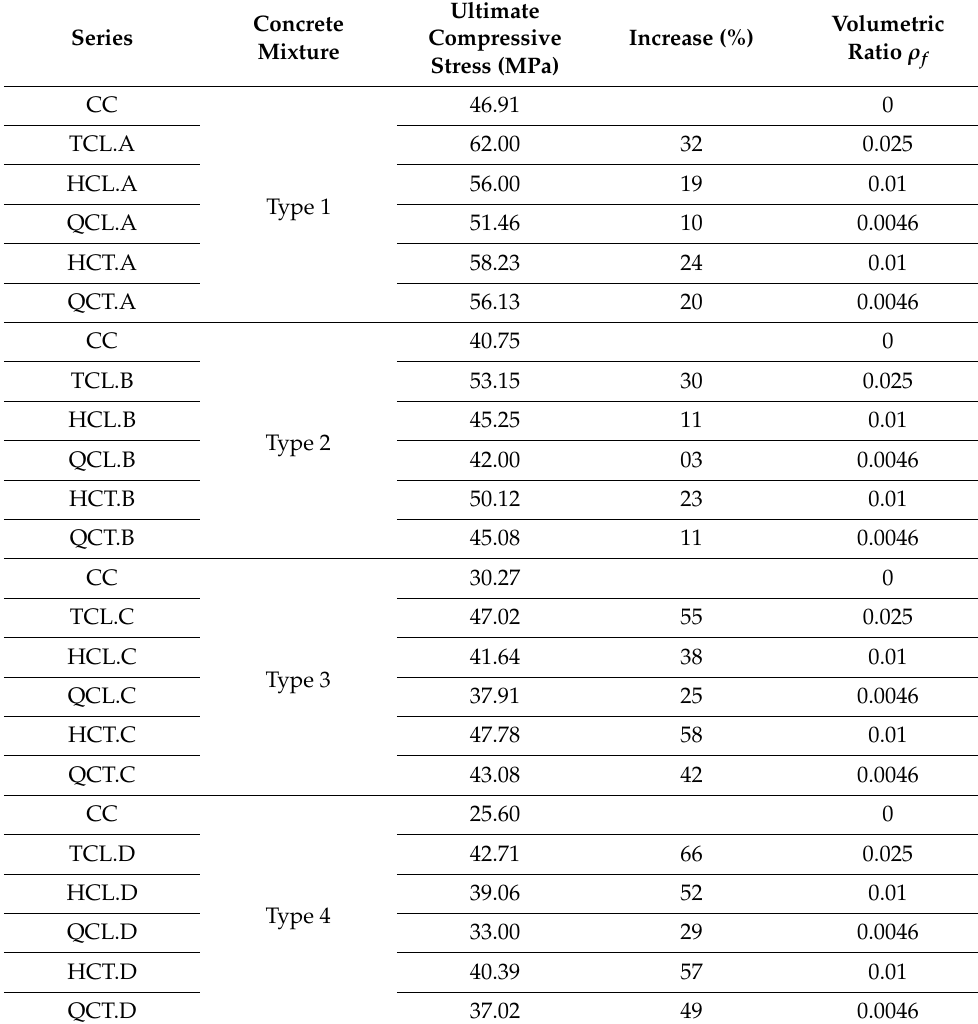
Table 6. Specimens’ experimental results of the compressive strength.